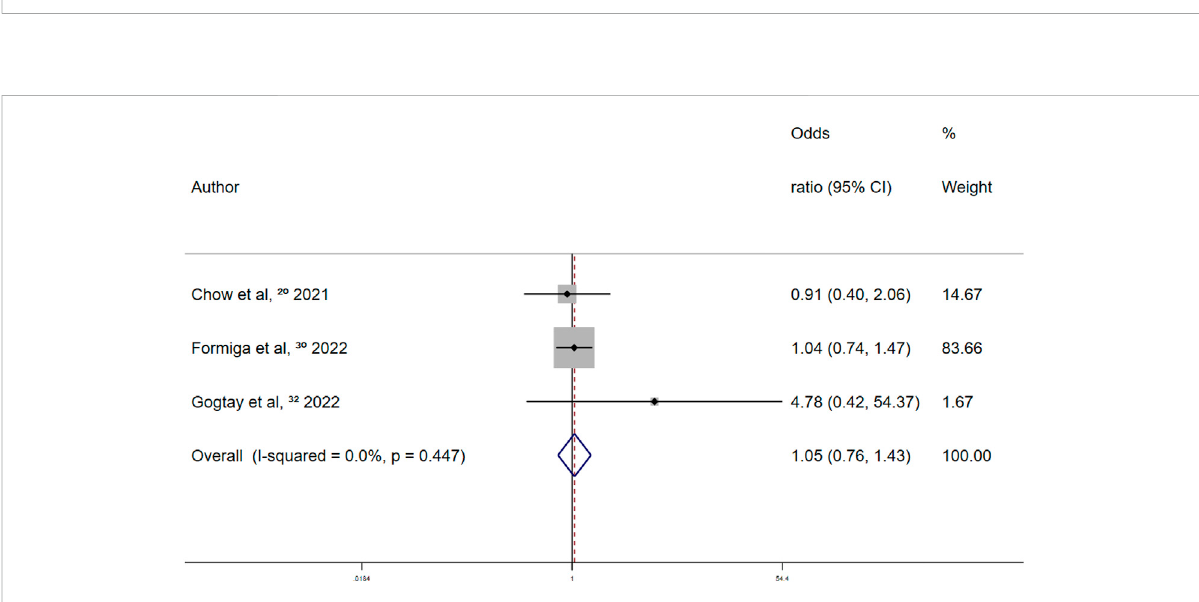
FIGURE 10 Summary odds ratio of thrombotic events for aspirin use in retrospective